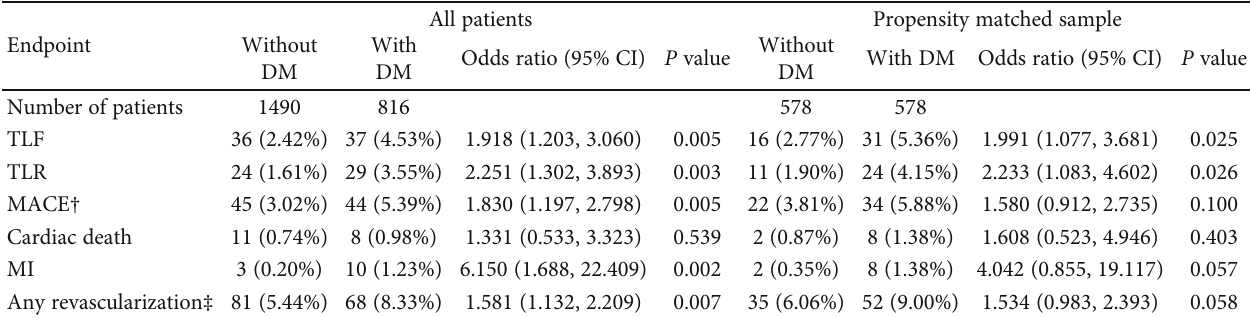
Table 3: Risk of primary and secondary outcomes in the propensity score-matched cohort at one-year follow-up. ∗